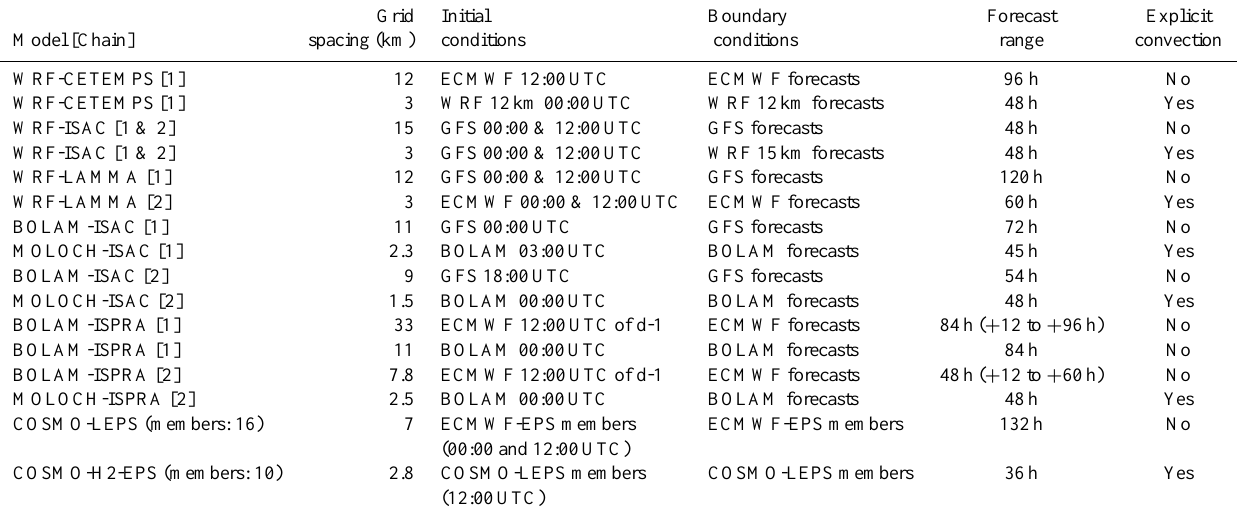
Table 4. Summary of the main characteristics of the model chains used by the different institutions for SOP1. The COSMO number of mem- bers is given in the brackets. The last column indicates whether the model calculates the convection explicitly (“Yes”) or uses a convective scheme (“No”). Grid Initial Forecast Explicit Model